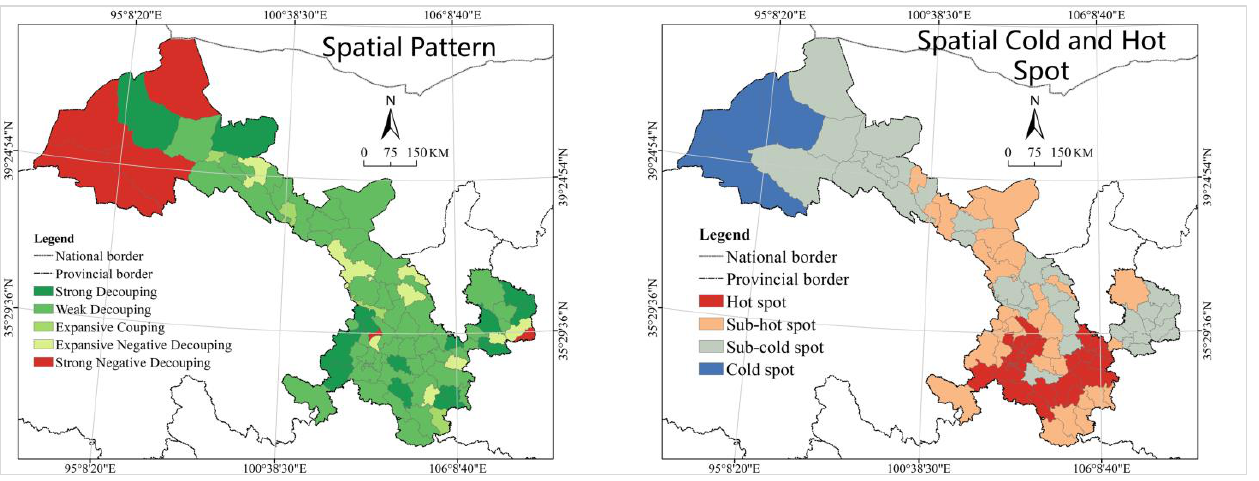
Figure 10. Spatial analysis on the decoupling relationship between urban construction land and added value of non-agricultural industries in Gansu.